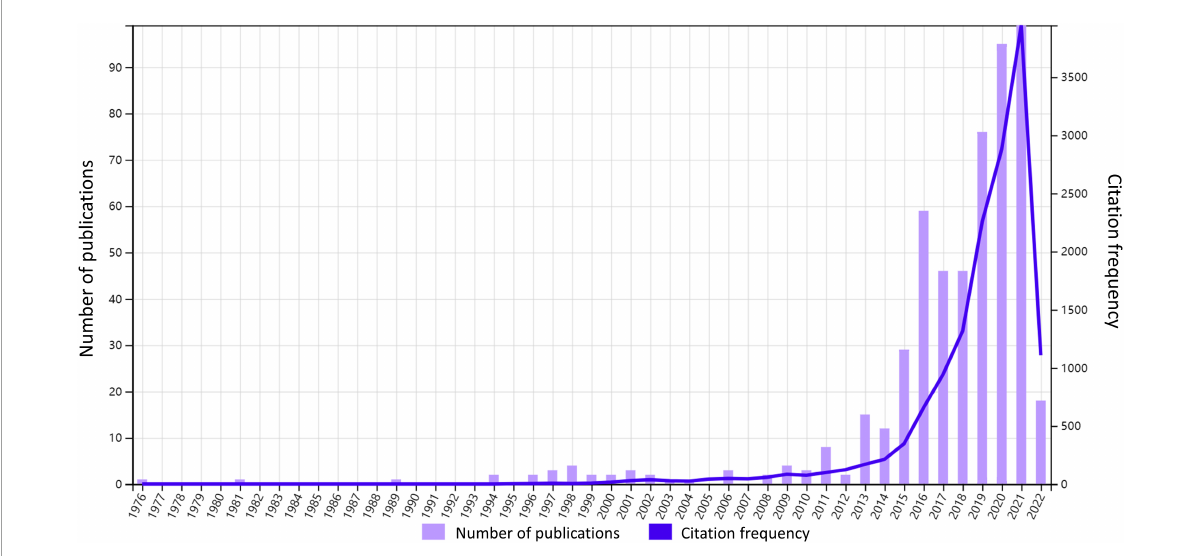
FIGURE1 Annual citation and publication. The number of annual publications and frequency of citations from 1976 to 2022 are shown in the